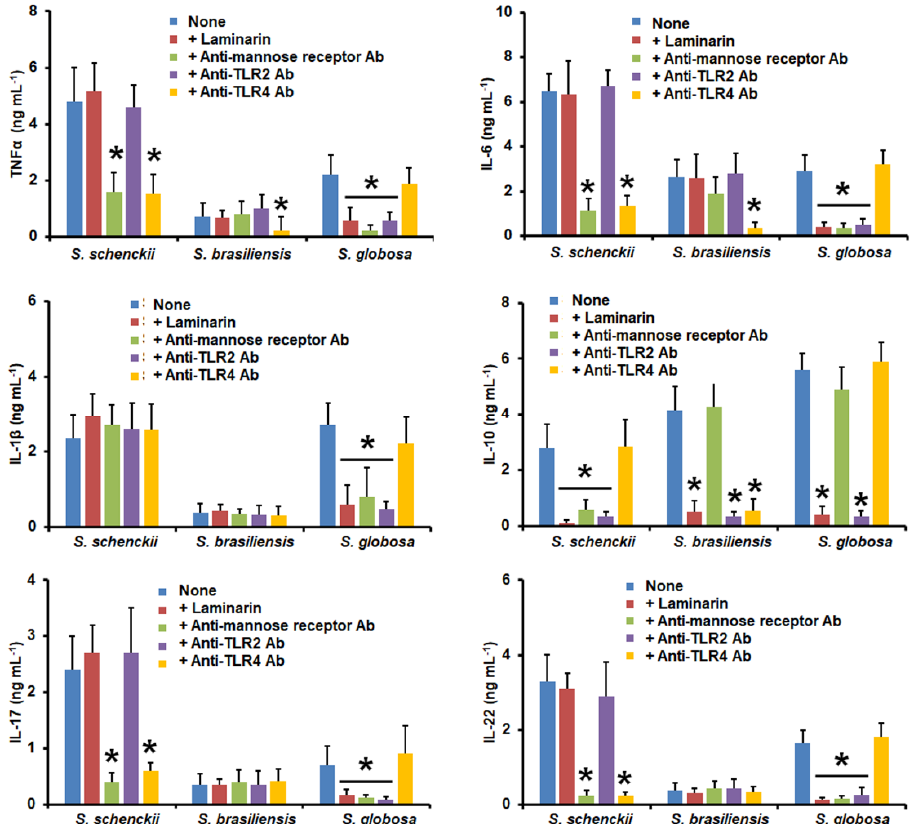
Figure 6. Cytokine production by human peripheral blood mononuclear cells pre-incubated with different blocking molecules and stimulated with conidia from Sporothrix schenckii , Sporothrix brasiliensis , or Sporothrix globosa . Human peripheral blood mononuclear cells were pre-incubated for 60 min with 200 µg mL − 1 of laminarin, 10 µg mL − 1 of anti-mannose receptor, 10 µg mL − 1 of anti-TLR2, or 10 µg mL − 1 of anti-TLR2, and then challenged with conidia. For tumor necrosis factor-alpha (TNF α ), interleukin 1 β (IL-1 β ), interleukin 6 (IL-6), and interleukin 10 (IL-10), human peripheral blood mononuclear cells were co-incubated for 24 h with live conidia, whilst for interleukin 17 (IL-17) and interleukin 22 (IL-22) stimulation, the human cells were co-incubated with the UV-killed conidia. In all cases, the interactions were centrifuged, supernatants collected, and cytokines quantified by ELISA. Ab—antibody; S. — Sporothrix . None refers to the system where the human cells were pre-incubated only with PBS. Results are the median ± standard deviation from data generated with samples from eight donors, analyzed in duplicate. * p < 0.05 when compared with the cytokine level stimulated by PBS-pre-incubated cells.